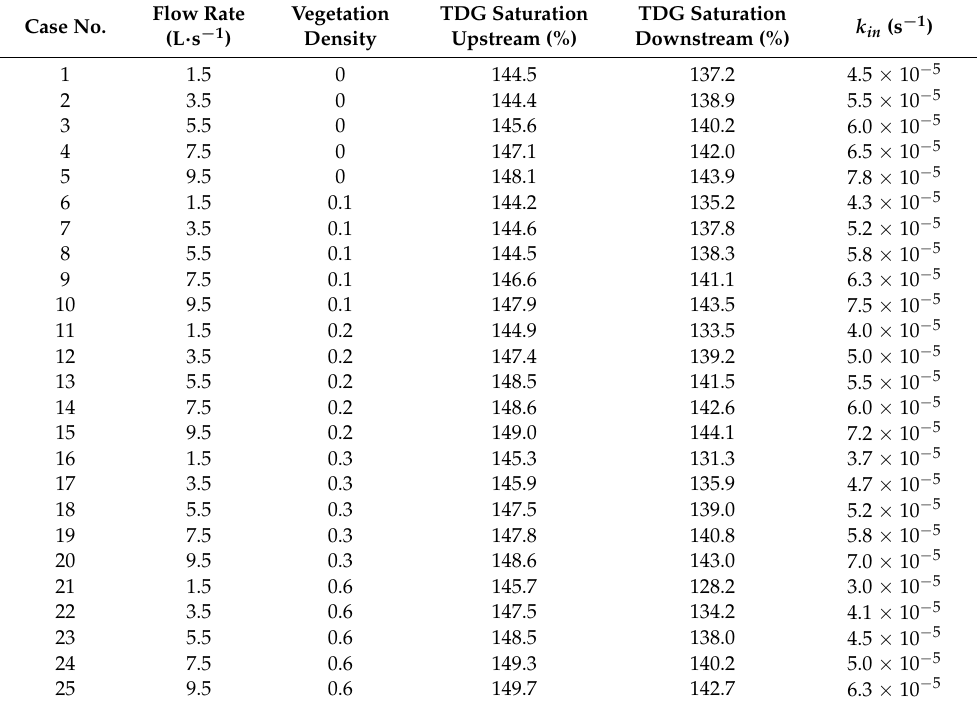
Table 2. Calibration results of inner dissipation